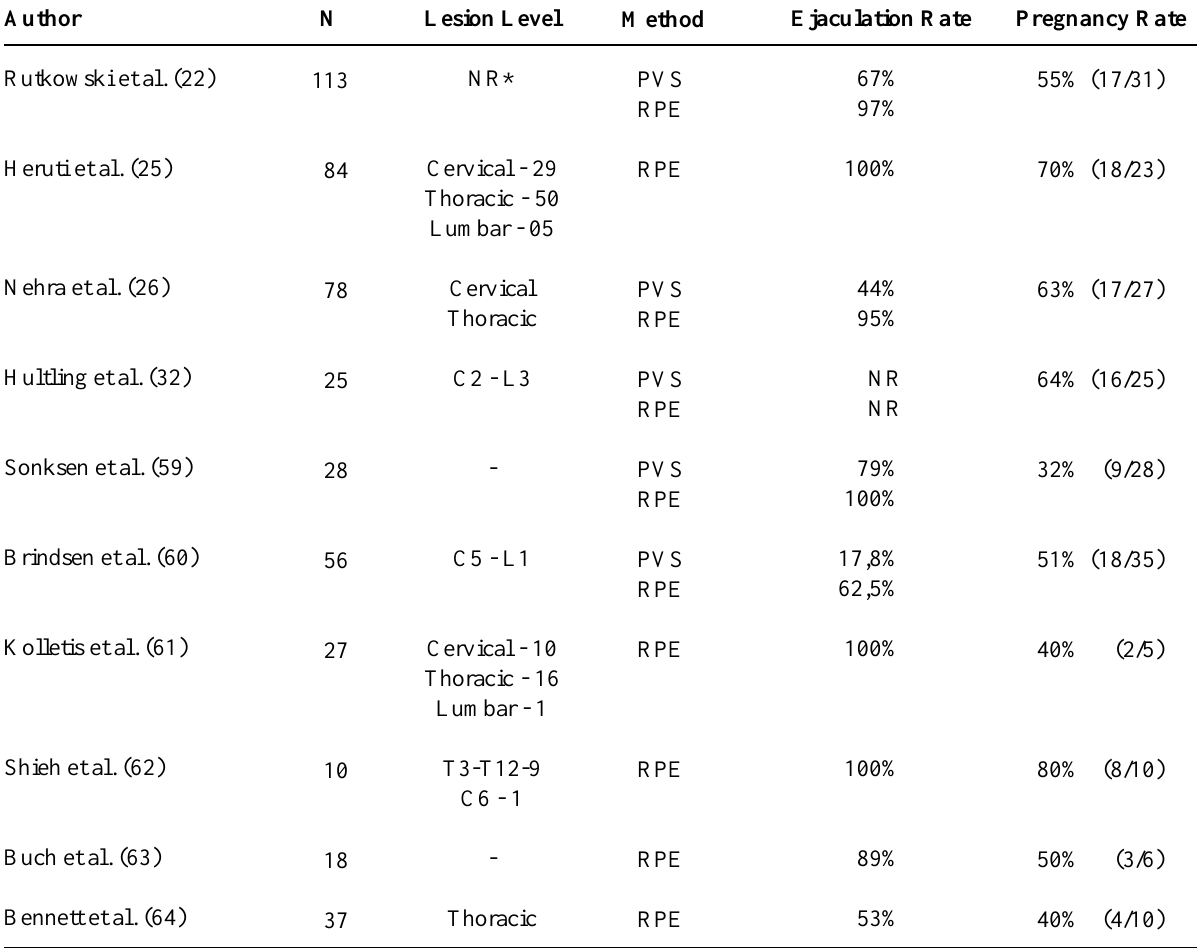
Table 1 – Results with vibratory ejaculation (PVS) and electro-ejaculation (RPE) for obtaining semen and pregnancy rate in patients with spinal cord